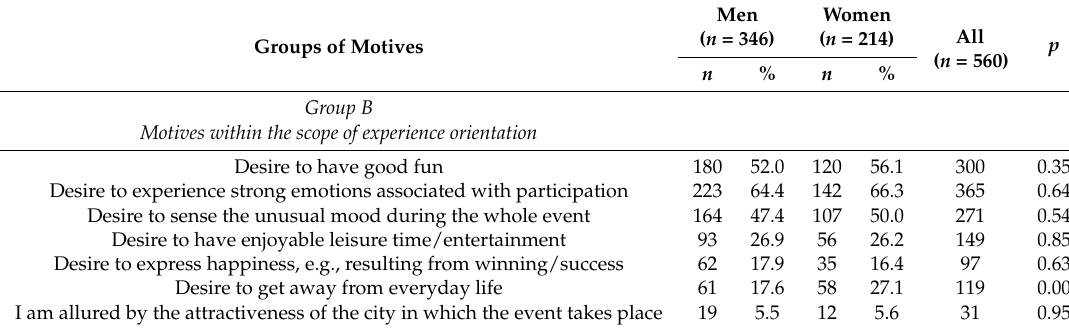
Table 8. Motives within the scope of experience